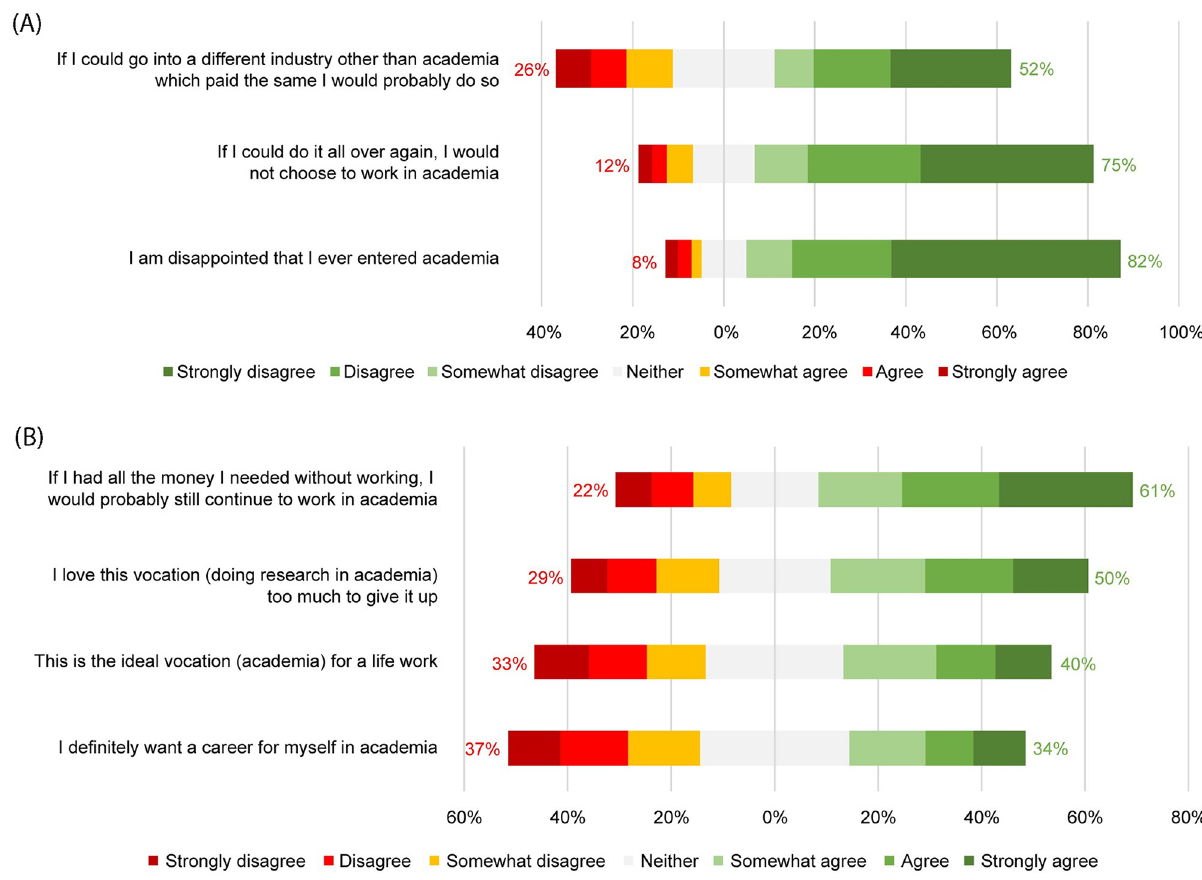
Fig 5. Vocational commitment.